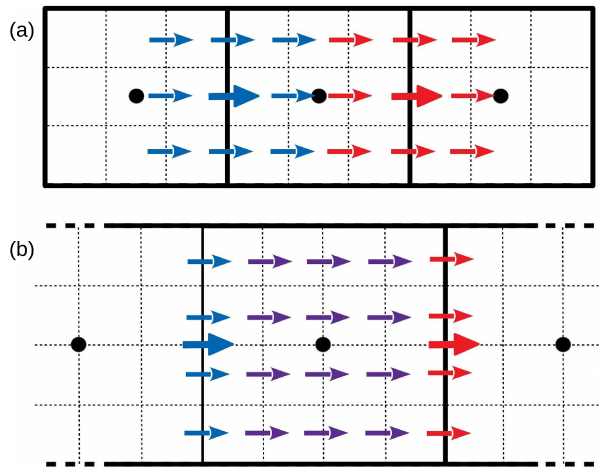
Figure 3. Staggered velocity component nodes in cases of odd (3) (a) and even (4) (b) grid-spacing ratios. The staggered velocity com- ponent nodes are shown as arrows: thick arrows are for the par- ent grid, and thin arrows are for the child grid. The parent scalar grid cell faces are drawn with solid lines, and the corresponding child grid cells are drawn with dotted lines. Locations of the corre- sponding parent grid scalar nodes are shown as black dots. The blue color indicates the left-hand parent grid node, and red indicates the right-hand node. In (a) the child grid values could be obtained from Eq. (8), which cannot be applied to (b) . The violet-colored child grid nodes in (b) receive the averaged values according to Eq.